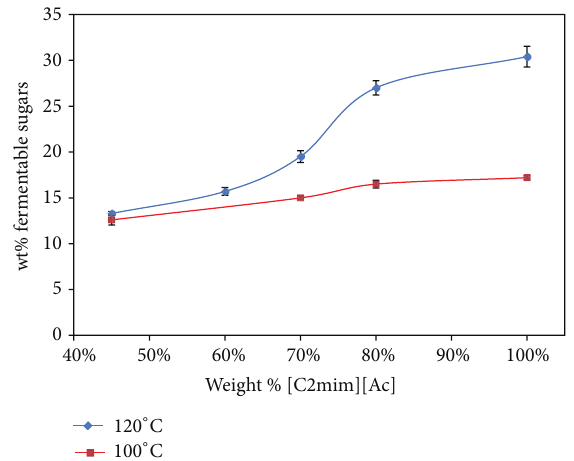
Figure 4: Total fermentable sugar yields relative to weight of jatro- pha shell released from jatropha shell at different temperatures after